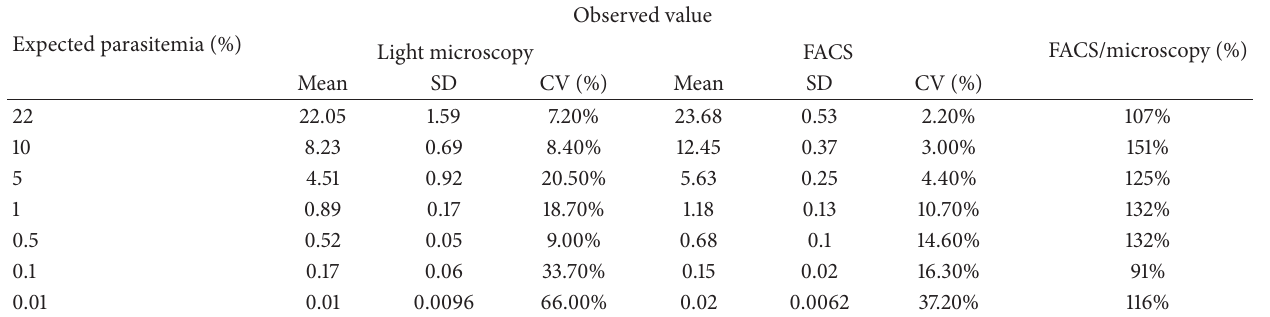
Table 1: Comparison of FACS with SYBR Green I and Giemsa stained microscopic analyses for the determination of malaria parasitemia. Expected parasitemia (%)